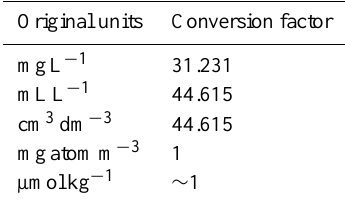
Table 1. Conversion factors to transform oxygen concentrations from the original reported units to µmolL − 1